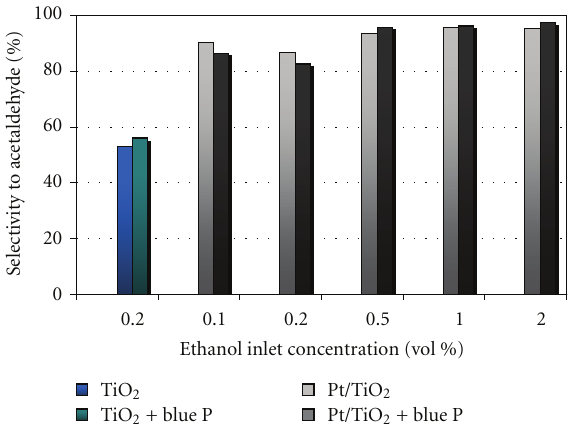
Figure 10: Acetaldehyde selectivity as a function of ethanol inlet